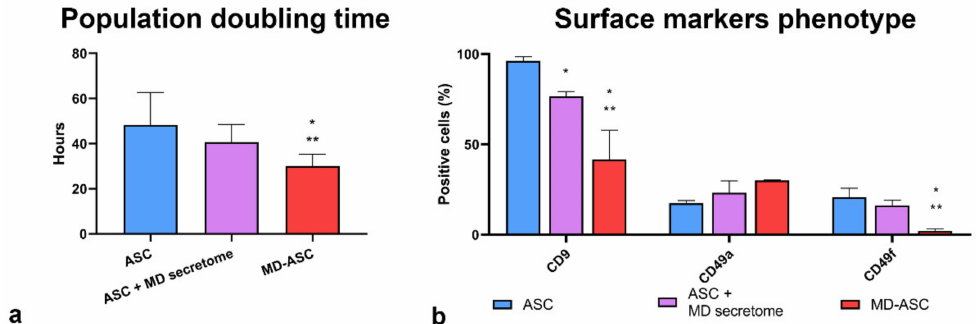
Figure 5. Influence of the MD-ASC secretome on ASC phenotype: ( a ) histogram comparing the mean population doubling times of ASC, ASC conditioned with MD-ASC, and MD-ASC and ( b ) surface marker expression comparison of CD9, CD49a, and CD49f in either ASC, ASC conditioned with MD-ASC secretome, or MD-ASC. Results are expressed as mean ± standard deviation. * p < 0.05 vs. ASC cells; ** p < 0.05 vs. ASC + MD-ASC